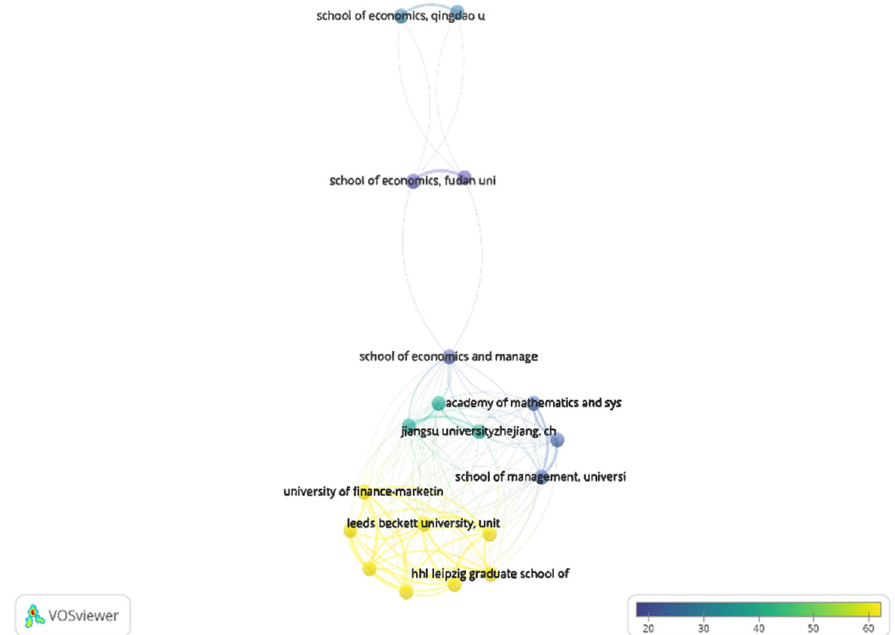
Figure 8. Bibliometric coupling of institutions using institution names as units of analysis.